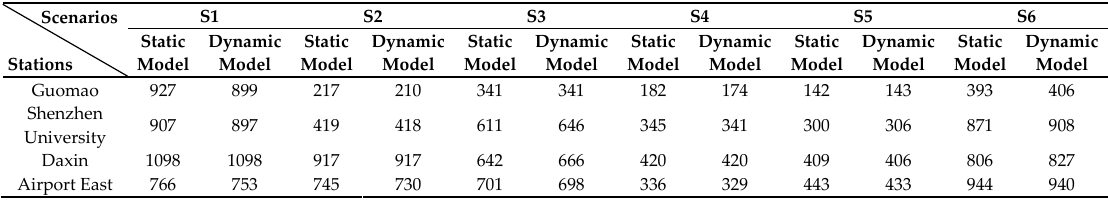
Table 5. The estimated transfer volumes of four stations under six scenarios.